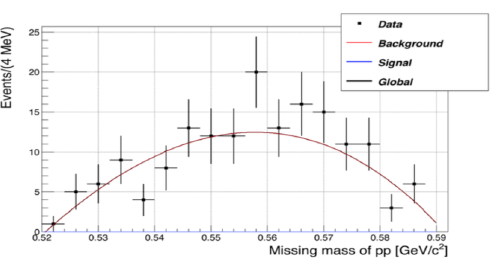
Figure 7. Illustration of the pp missing mass fitting procedure for an initial selection of events.